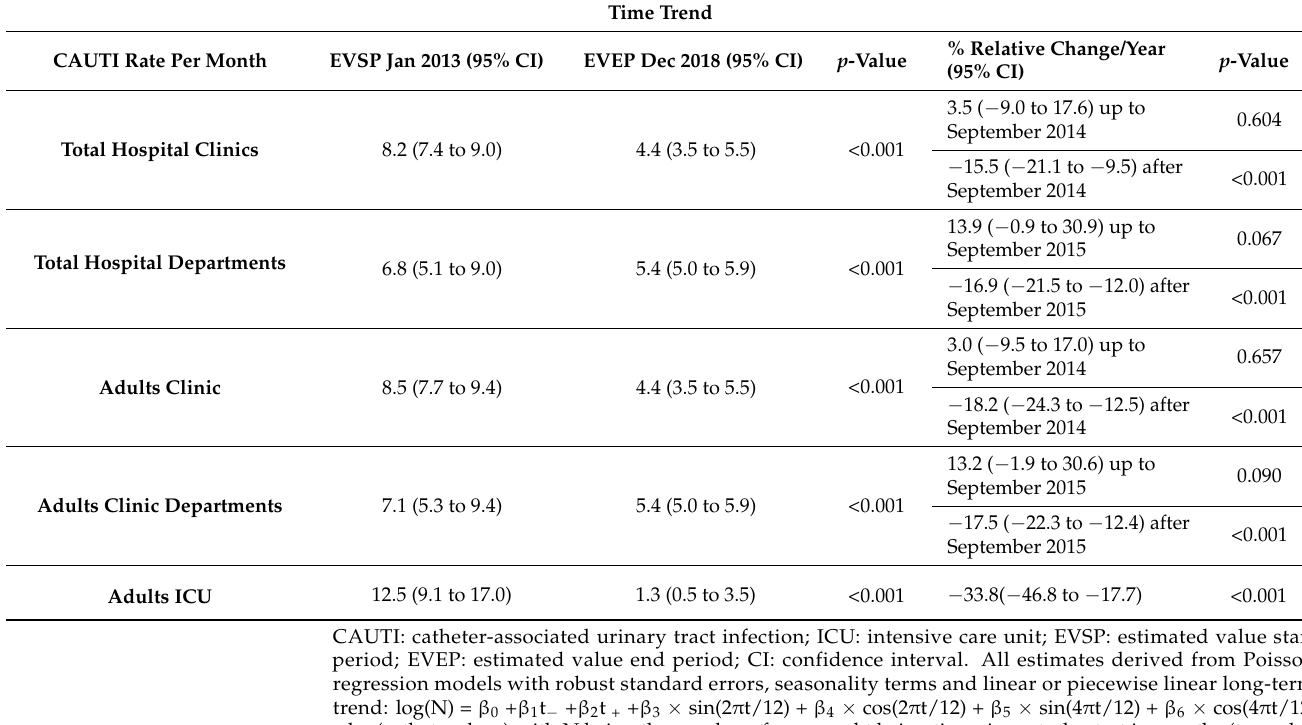
Table 1. Time trend of CAUTI rate in a hospital from January 2013 to December 2018.